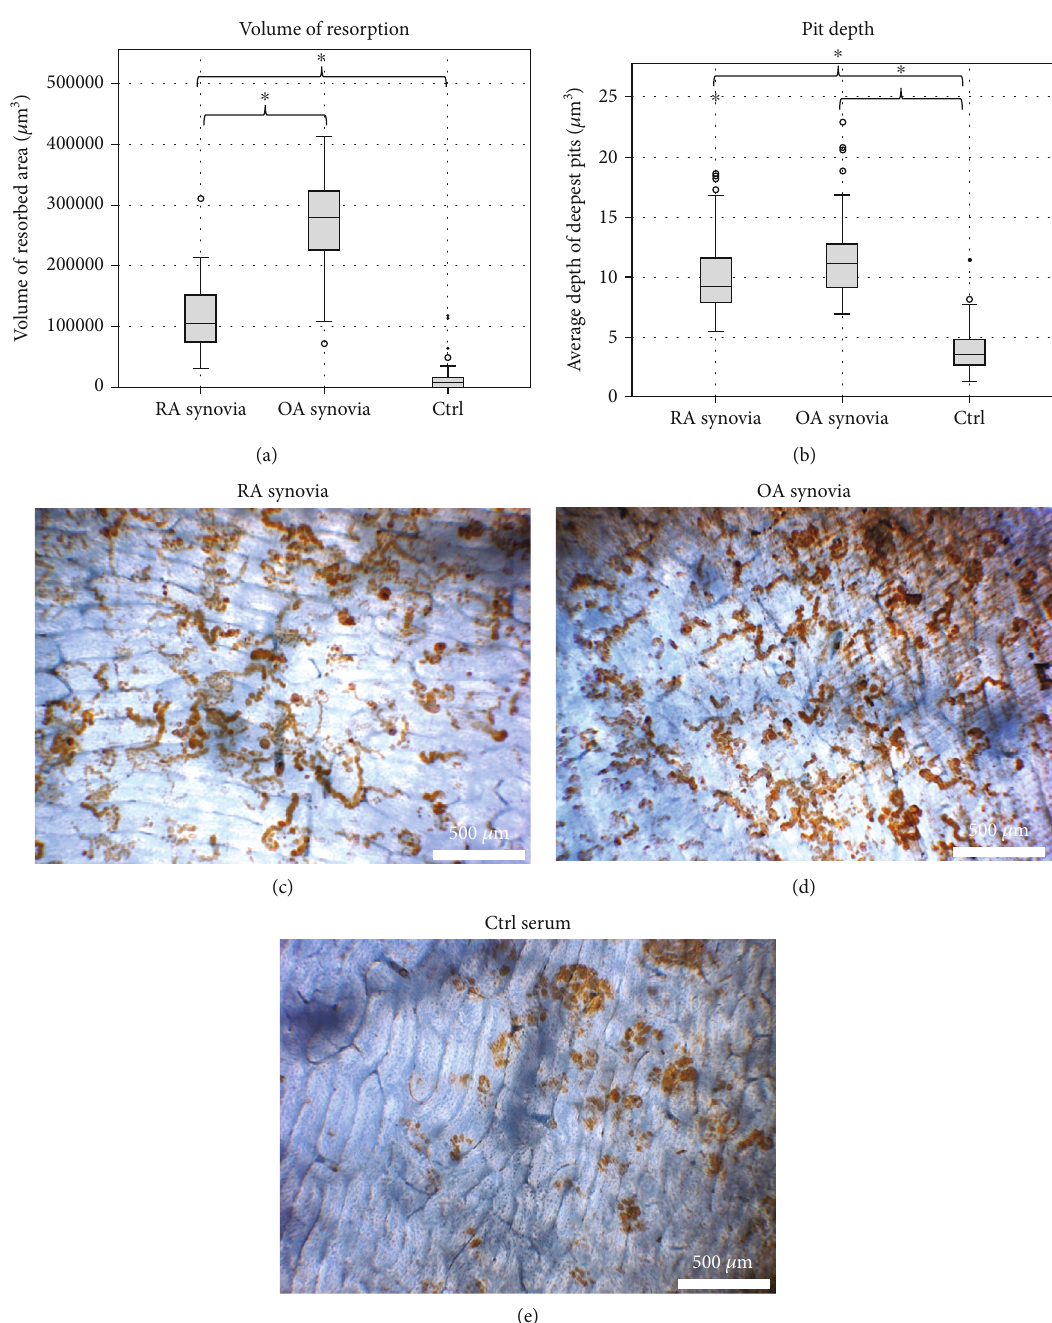
Figure 6: Bone resorption in cultures with RA and OA synovial fl uid. Panel (a) shows the average resorbed bone volume measured with a laser microscope from the synovial fl uid experiment. Example WGA-lectin stains of resorption pits on the bone slices from the cultures using RA and OA synovial fl uids and healthy serum are shown in panels (c – e). 4x magni fi cation. It was visually evident that the bone slices from the cultures with OA synovial fl uid showed the most